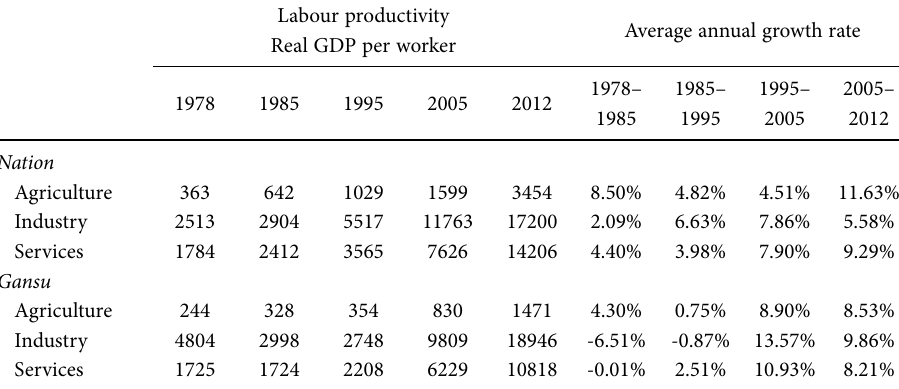
Table A. Growth of labour productivity in national average and Gansu,